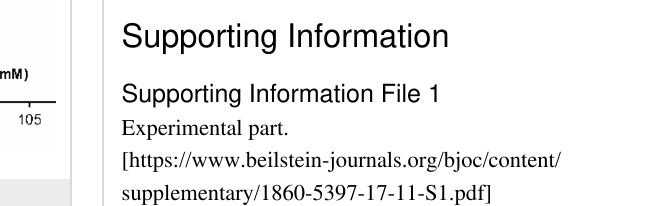
Figure 8: Specific viscosity of compound 4 in Nynas NS8 and Nexbase 3020 .